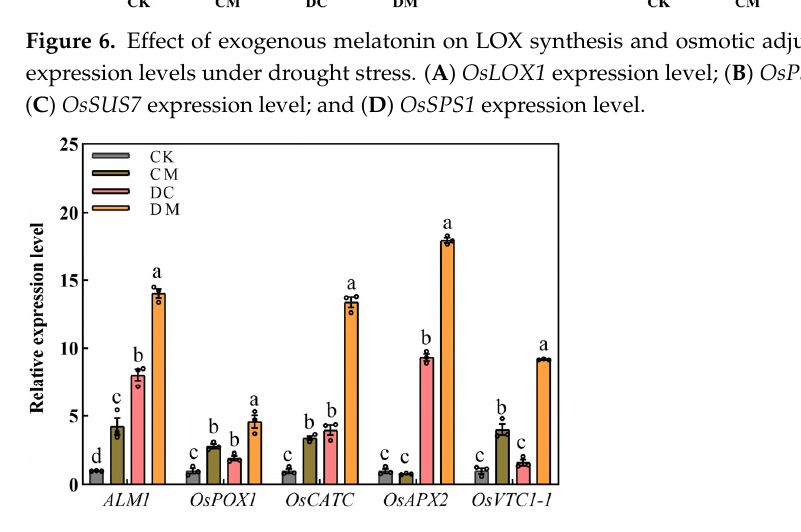
Figure 8. Effect of exogenous melatonin on melatonin synthetase gene expression levels under drought stress. 2.8. Correlation Analysis between Melatonin Biosynthesis-Related Genes and Antioxidant Enzyme Synthesis Genes Exogenous melatonin also functions as an antioxidant to protect plants against in- trinsic oxidative stress and drought. Gene expression levels were used to evaluate the link between the two to investigate the correlation between genes involved in melatonin biosynthesis and those synthesizing antioxidant enzymes under drought stress. The outcomes showed that the R 2 values between TDC2 and the genes that make antioxidant